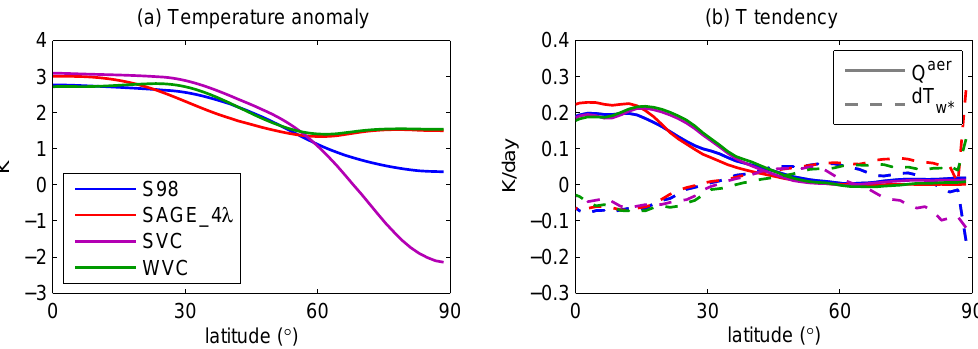
Figure 11. Lower stratospheric (100–20hPa), DJF average thermodynamic quantities from the four volcanically forced ensembles: (a) tem- perature anomalies, (b) temperature tendencies due to aerosol radiative heating Q aer (solid lines) and vertical advection (d T w ∗ , dashed